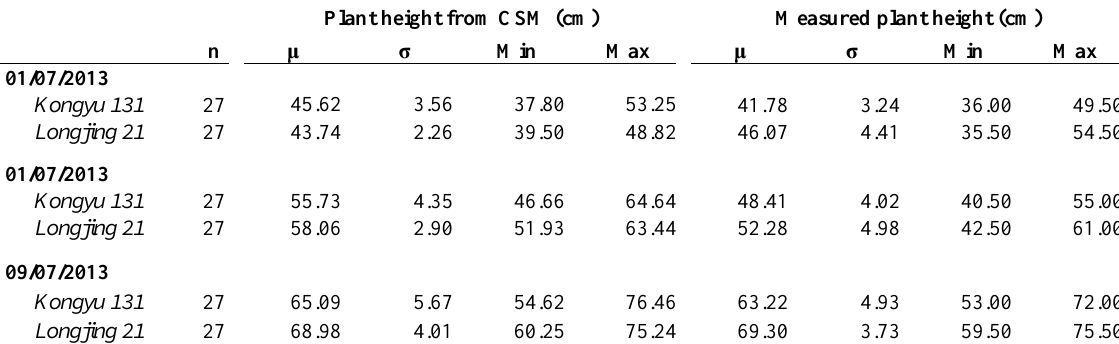
Table 1. Mean CSM-derived and manually measured plant heights. Plant height from CSM (cm) Measured plant height (cm)